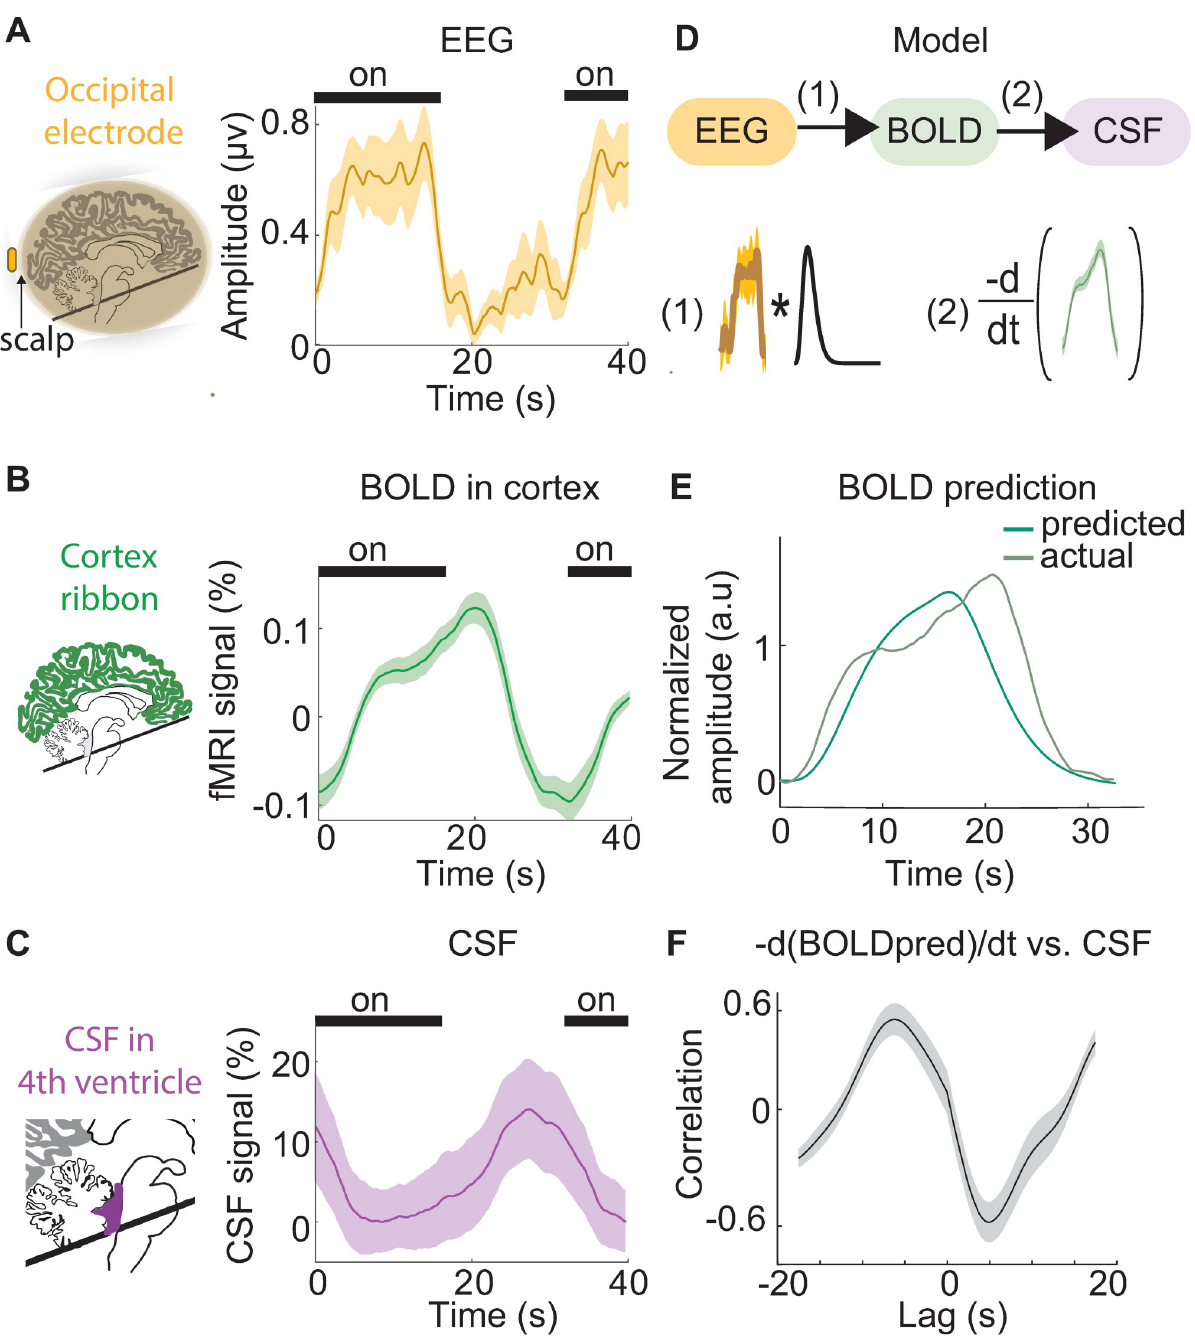
Fig 2. The temporal sequence of simultaneously measured neural, hemodynamic, and CSF signals. ( A ) The average amplitude envelope (orange) of stimulus-locked occipital EEG shows consistent neural responses during the visual stimulus ( n = 12 runs, 6 subjects). ( B ) The average global cortical response (green) shows the stimulus induces a global increase in BOLD detectable in the cortical gray matter ROI. ( C) The average CSF inflow signal (purple) shows consistent upwards flow after stimulus offset, when BOLD is decreasing. Shading in all panels indicates the standard error across 12 task runs. Black bars indicate stimulus ON blocks. Time t = 0 is the onset of a 16-s ON block. ( D ) A schematic of the model for predicting CSF flow using neural signals. The EEG envelope amplitude (orange) is convolved with a standard hemodynamic response function (black). The negative temporal derivative of the predicted hemodynamic signal (green) is then used to predict CSF flow. ( E ) The predicted BOLD signal produced by convolution overlaid on the actual BOLD signal. ( F ) The cross-correlation between the negative derivative of the predicted BOLD signal and CSF signal, showing that model predictions correlate with observed CSF flow. Shading is standard error across subjects ( n = 6). Data from: doi:10.18112/openneuro. ds004478.v1.0.0. BOLD, blood-oxygenation-level-dependent; CSF, cerebrospinal fluid; EEG, electroencephalogram; ROI, region of interest.